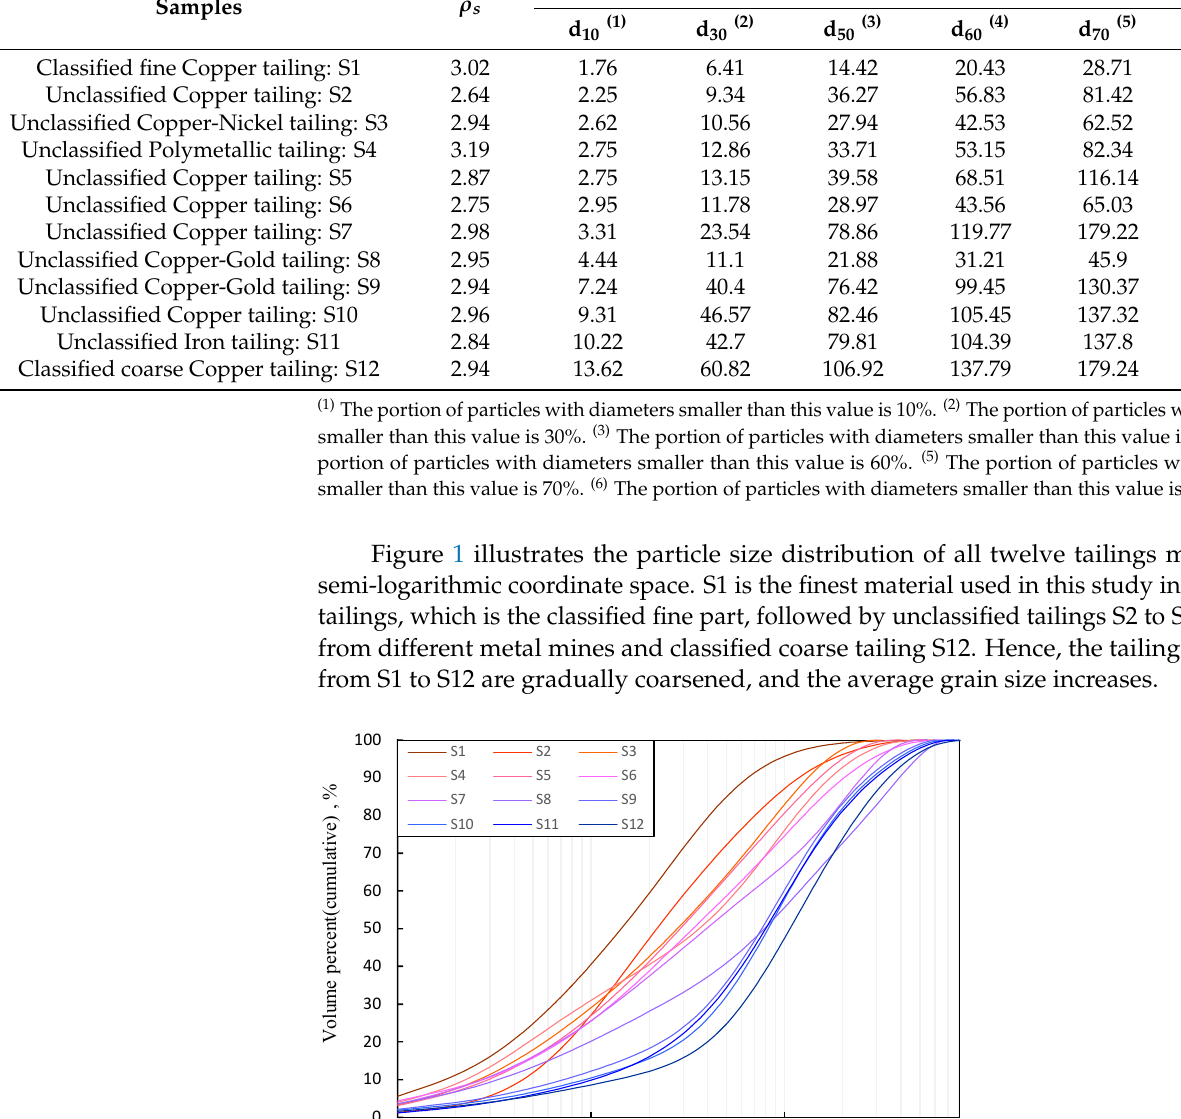
Table 1. The particle size distribution and specific gravity of tailings.